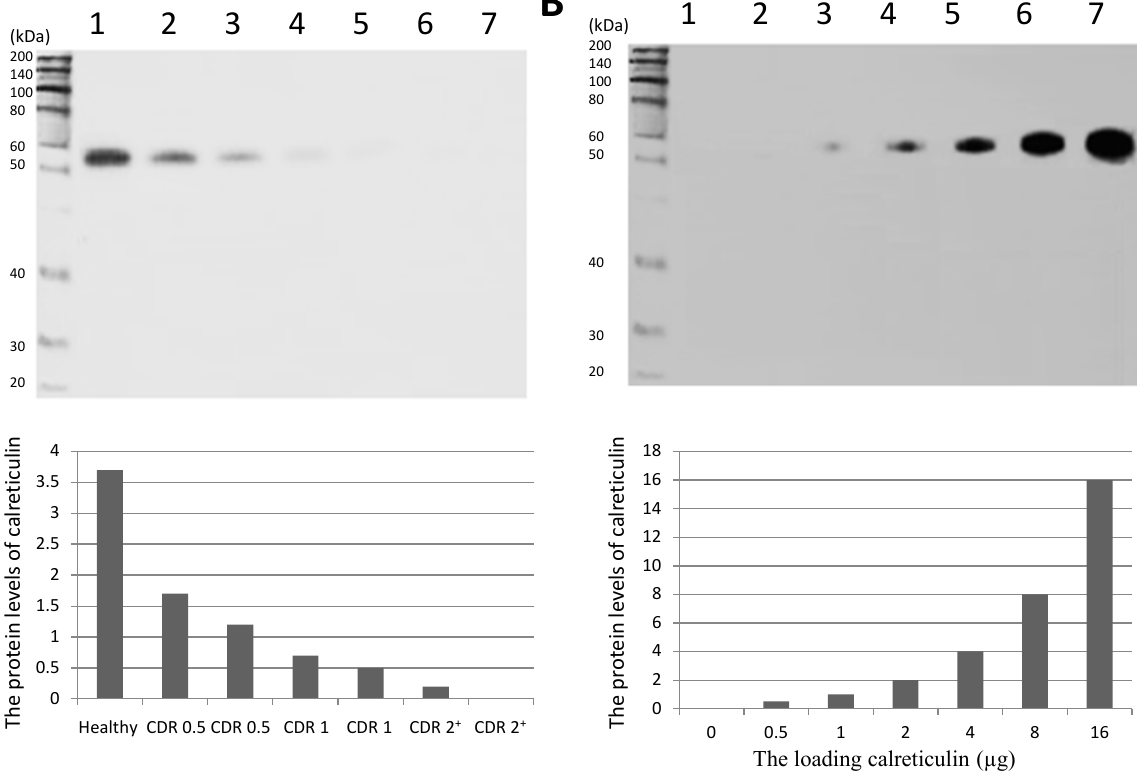
Figure 3. Western Blot analysis of serum calreticulin of AD patients and healthy subjects. ( A ) serum levels of calreticulin in AD patients and healthy subjects. Lane 1, a healthy control; Lanes 2–7, AD patients and ( B ) lanes 1–7, 0, 0.5, 1, 2, 4, 8 and 16 µg of calreticulin was loaded in respectively. A band of approximately 55-kDa protein could be detected (predicted molecular weight: 48